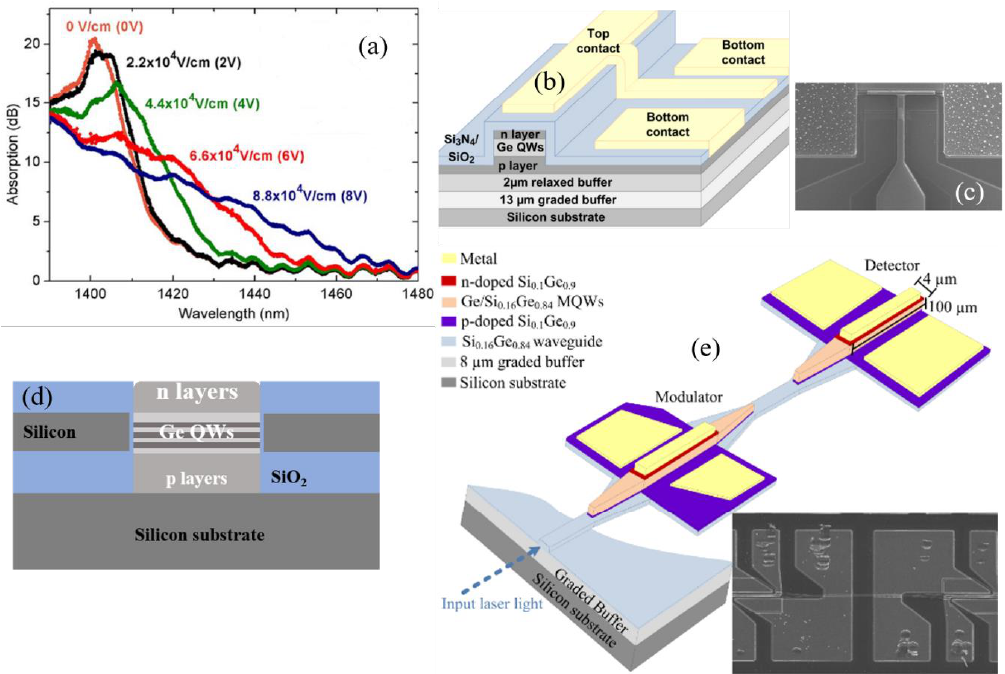
Figure 2. ( a ) QCSE from a Ge/SiGe MQW 34-µm-long planar waveguide obtained from optical transmission measurements [43], and ( b ) a stand-alone Ge/SiGe MQW waveguide optical modulator. ( c ) Scanning electron microscope (SEM) image of the stand-alone optical modulator [46]. ( d )